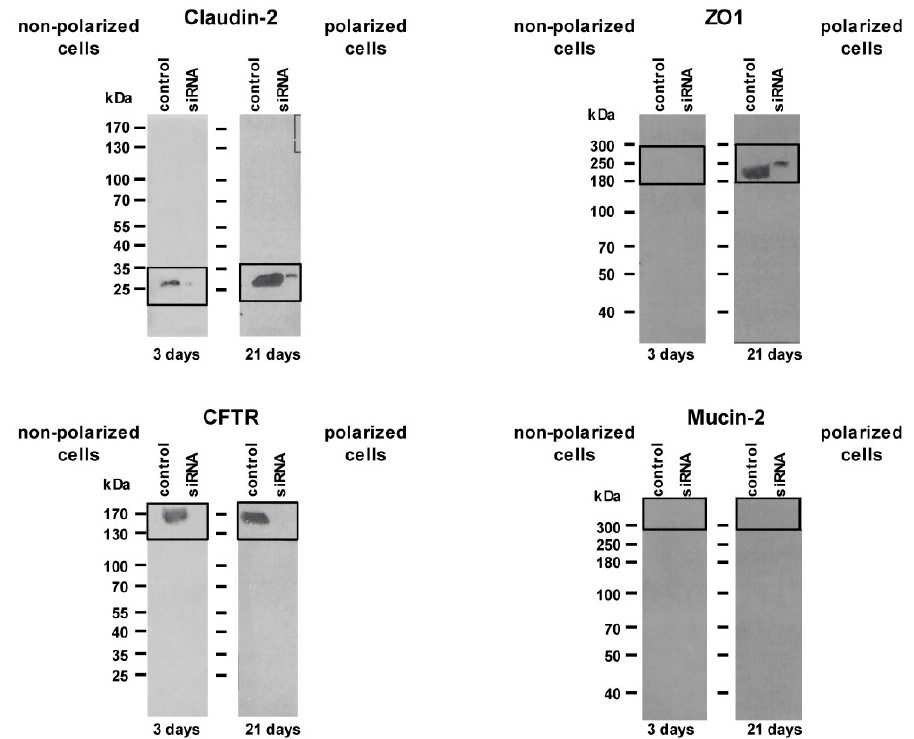
Figure 1. Western blot with non-polarized (three days cultured) and polarized (21 days cultured) MzChA-1 cells with representative proteins of the tight junction (TJ) complex (claudin-2; Zonula Occludens-1, ZO1). Cystic fibrosis transmembrane conductance regulator (CFTR) is a constitutive, non-TJ protein used as housekeeping gene, and mucin 2 as a protein that is not expressed in cholangiocytes. Applied were 30 µ g of cell homogenates. The data indicate the enhancement of appearance of the TJ proteins claudin-2 and ZO1 with the polarization of the cells.